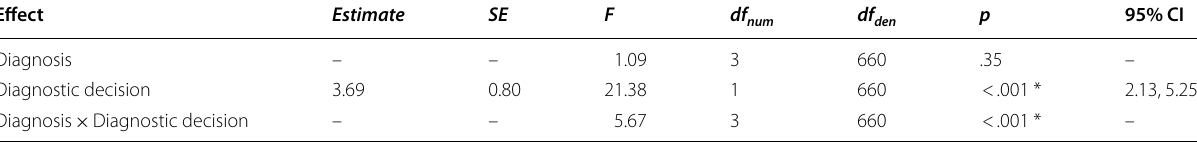
Each effect was entered as a fixed effect in a multilevel linear model, along with a random intercept for participant. Type III F tests with Kenward-Roger estimations for degrees of freedom are reported. An asterisk (*) denotes p < .05